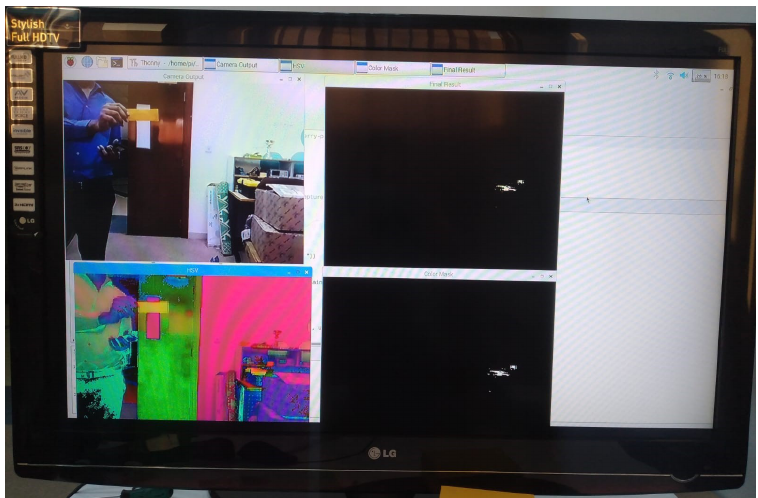
Figure 12. The interface of the color-filtering process.